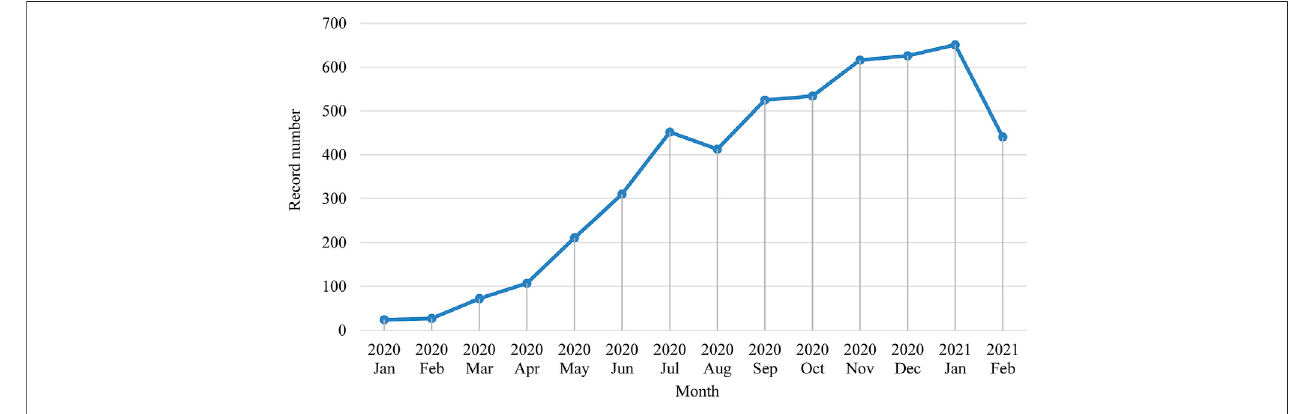
FIGURE 2 | Monthly trend of the number of publications.